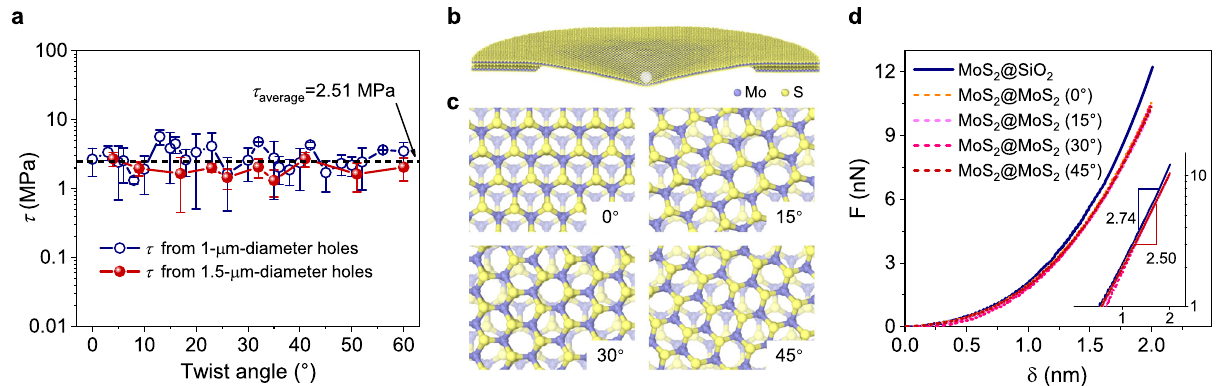
Fig. 4 Twist-angle-independent shearing in TBLM. a Independence of shear stresses of TBLM samples on twist angles. Error bars represent standard deviations. The dashed line marks the average τ ( τ average ) in all TBLM samples measured over 1- μ m-diameter and 1.5- μ m-diameter holes. b Atomic con fi gurations of the simulated system. The white sphere represents a nanoindenter with a radius of 1 nm. c Top views of indented MoS 2 monolayer with different twist angles relative to the MoS 2 substrate. d Nanoindentation force – displacement ( F - δ ) curves obtained from molecular dynamics simulations, also indicating that the interlayer mechanical interaction remains constant regardless of twist angles. The inset shows the scaling exponents of the